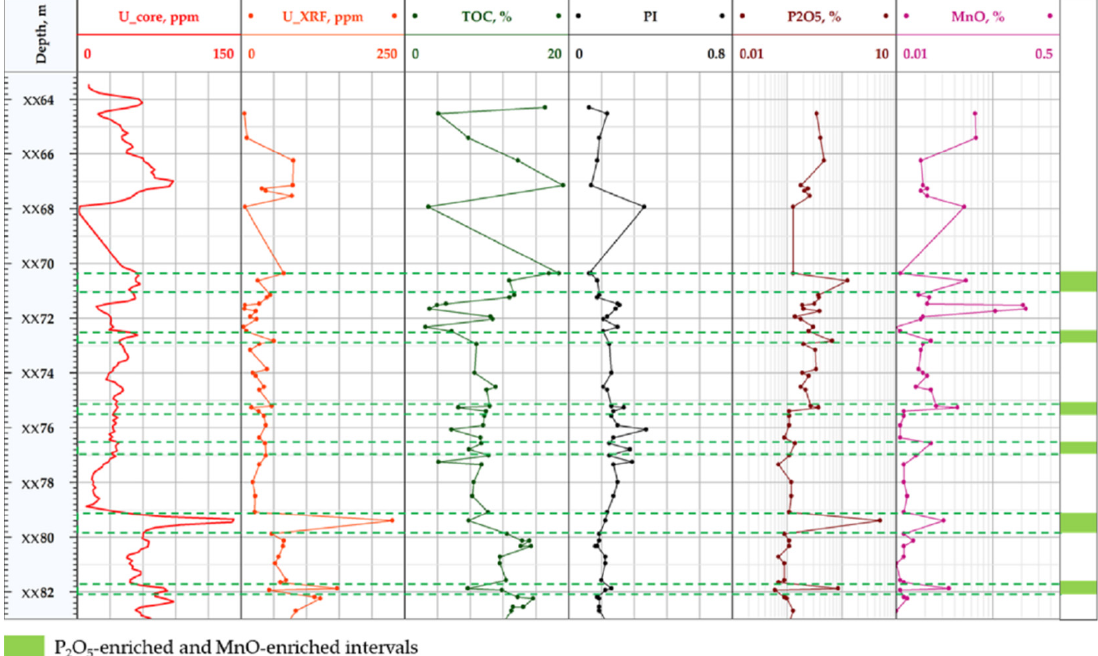
Figure 15. Example of depth distributions of MnO, P 2 O 5, and uranium concentration (from gamma- ray spectrometry on core samples and XRF), as well as pyrolysis productivity indices (PI) and total organic carbon (TOC).